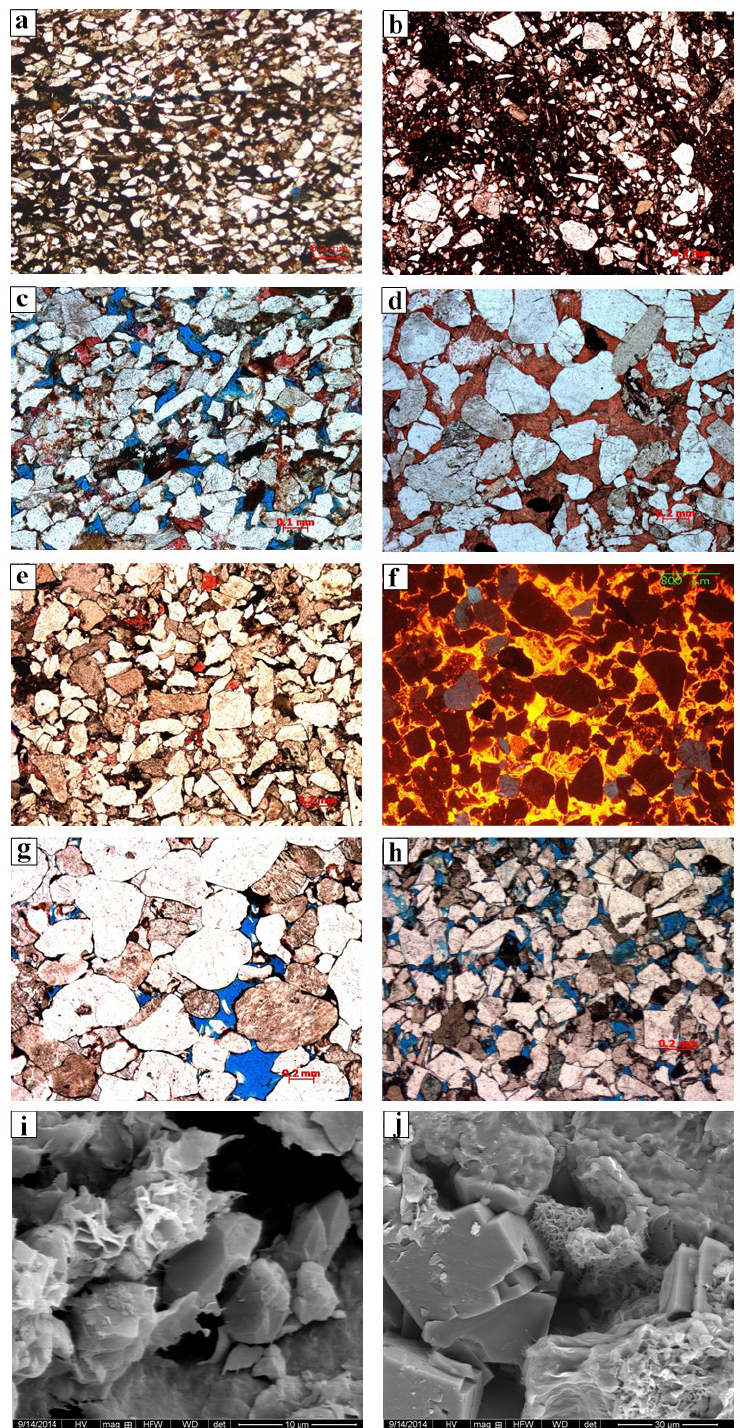
Figure 5. Thin section, CL and SEM images showing the diagenesis type and degree as well as diagenetic minerals of Cretaceous Bashijiqike Formation in Kuqa Depression (Xin et al., 2022). (a) Tightly compacted rocks, very fine-grained, Dabei 902, 5097.15m. (b) Poorly sorted rocks which are tightly compacted, Dabei 1102, 5921.26m. (c) Intergranular pores preserved in well-sorted rocks, Dabei 14, 6351.16m. (d) Extensive carbonate cements, Dabei 1101, 5895.76m. (e) Dolomite cements, Dabei 1101, 5809.35m. (f) CL images showing the ex- tensive carbonate cements, Dabei 12, 5442.09m. (g) Dissolution pores due to dissolution of framework grains, Dabei 1102, 5915.51m. (h) Intergranular and intragranular dissolution pores, Keshen 242, 6564.1m. (i) Authigenic quartz and illite and smectite mixed layer, Bozi 102, 6758.04m. (j) Illite and smectite mixed layer filling in the pore spaces, Bozi 102, 6763.16m. https://doi.org/10.5194/se-13-975-2022 Solid Earth, 13, 975–1002,